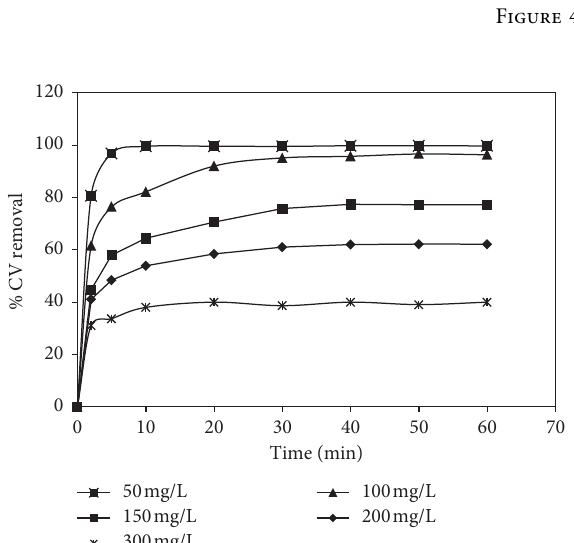
Figure 5: Effect of shaking time on the removal of CV.